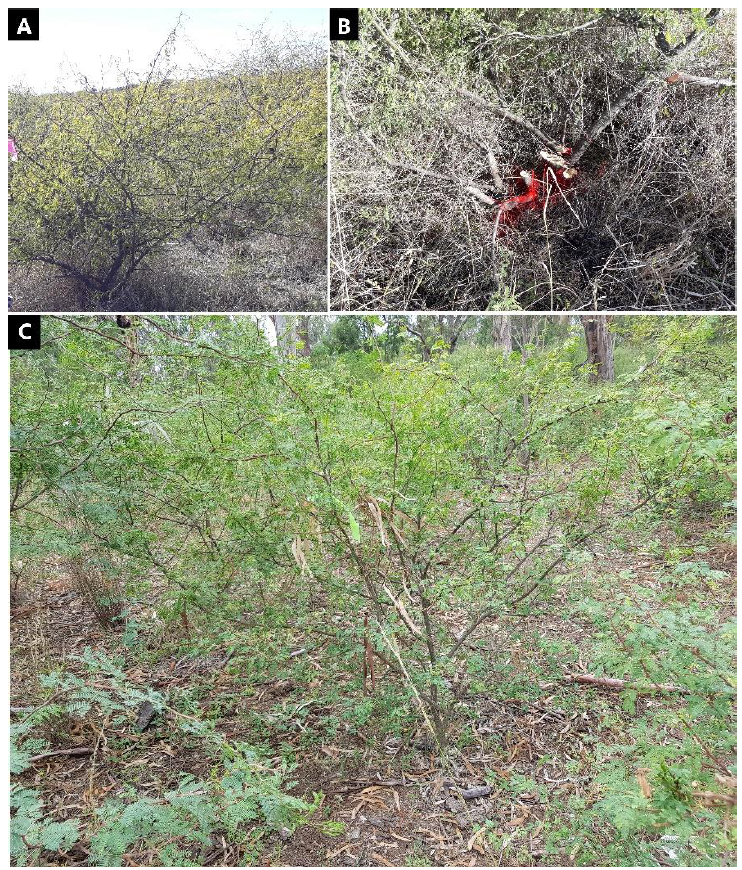
Figure 3. ( A ) & ( B ) Multi-stemmed plant in trial 1; ( C ) single-stemmed plant in trial 2. Table 1. Chemical herbicide treatments for the intact plant